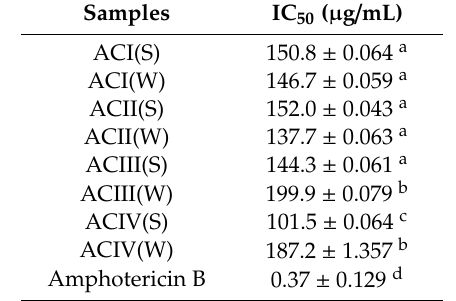
Table 2. Leishmanicidal activity of Arrabidaea chica Verlot extracts against promastigote forms of Leishmania amazonensis treated for 72